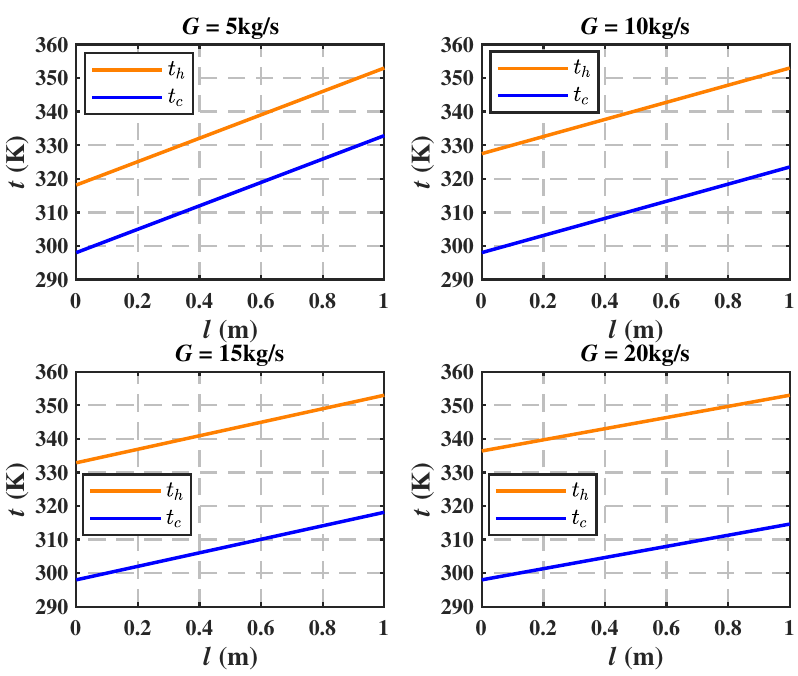
Figure 7. Temperature profiles of the streams with four pairs of heat capacity rates.